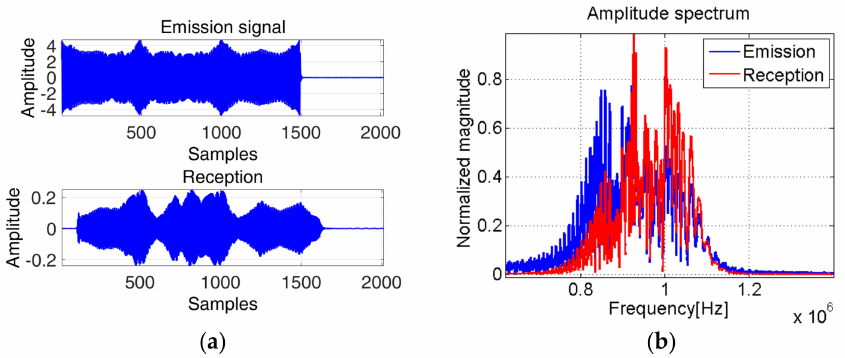
Figure 22. ( a ) The emitted and received signal in time; ( b ) The corresponding amplitude spectrum.